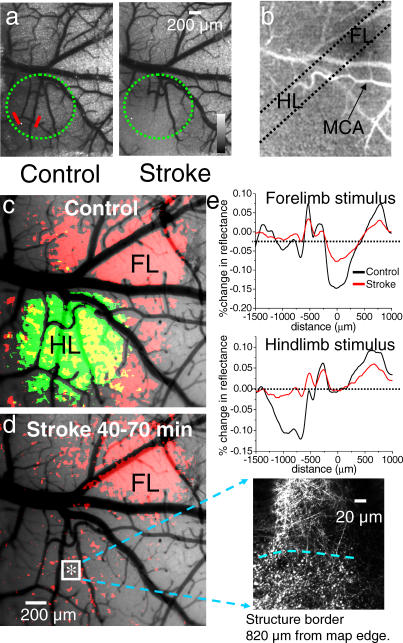
Dendritic Structural Borders after Complete Removal of the Hindlimb Functional Map(A) Laser-speckle surface blood flow image showing the approximate location of the hindlimb territory (green circle) and two sites where photoactivation of RB was performed using a fluorescence arc lamp (red lines). Right: laser-speckle image 20 min after stroke induction shows a loss of surface blood flow to at least half of the hindlimb territory.(B) Raw change in IOS after contralateral forelimb stimulation 40–70 min after stroke indicates a significant forelimb response (darkening in area under FL, images scaled from −0.1% to 0.1% change). In this image branches of the MCA (indicated) that supply both the forelimb and hindlimb area are seen in bright white. This image shows that part of the hindlimb territory is still undergoing changes in blood flow in response to activity.(C) IOS maps for hindlimb and forelimb regions in the animal before stroke induction. The mixed forelimb and hindlimb response presumably reflects some degree of noise (yellow pixels).(D) The hindlimb response was completely lost (no significant response was observed so a color map could not be created) 40–70 min after photothrombotic stroke, while a response in the forelimb area was still present. The white box and enlarged image to the right indicates the area where two-photon imaging established the border of dendritic damage.(E) Quantification of the forelimb and hindlimb IOS responses from smoothed line profiles over the region indicated in (B) by the dotted black lines. Upper panel: contralateral forelimb stimulation results in approximately 0.15% reduction in light reflectance. After stroke reflectance decreases to approximately 0.07%. Lower graph: the contralateral hindlimb stimulus response profile was completely lost following stroke as the red line was not different from 0. The contralateral hindlimb response was visible under control conditions and is observed (in the response profile graph) about −750 μm from the center of the forelimb area.